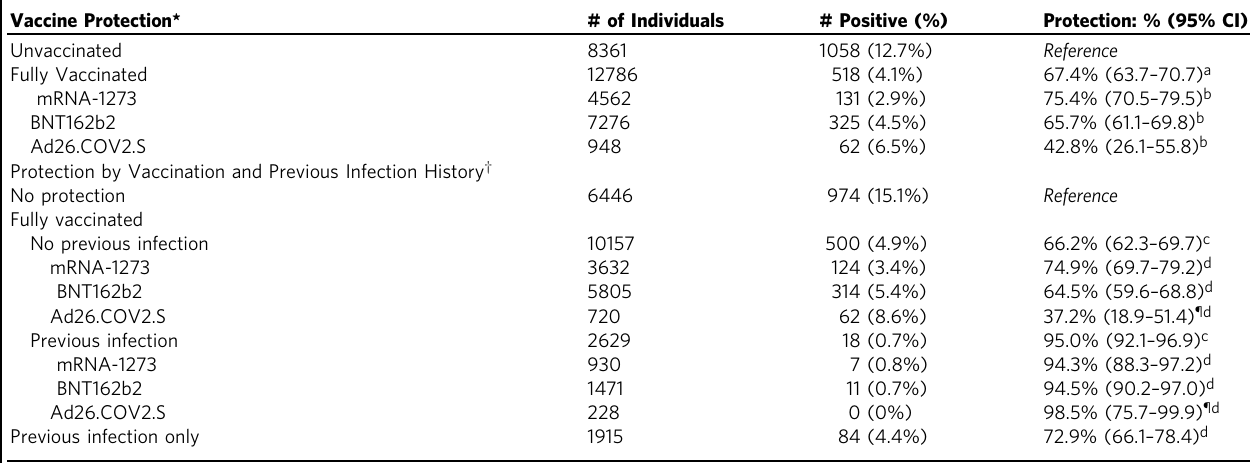
Table 2 Estimated protection from vaccination and previous infection against SARS-CoV-2 infection between August 8th, 2021 and December 4th, 2021.